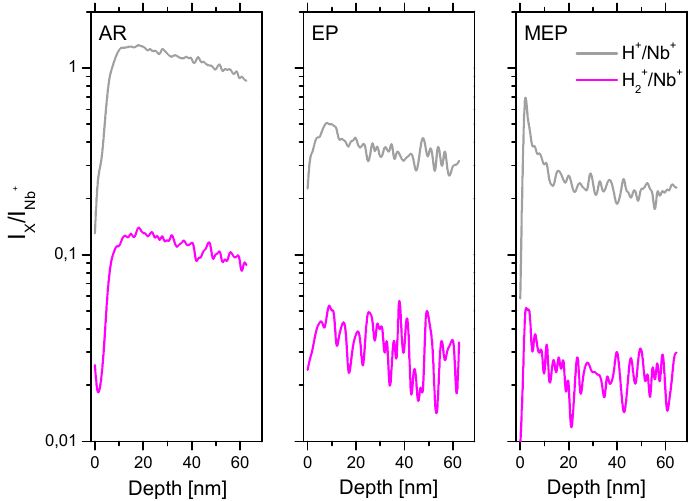
Figure 14. Dependence of rates of hydrogen positive secondary ions (H + and H 2 + ) currents to the secondary niobium ion currents on the depth of ion etching.